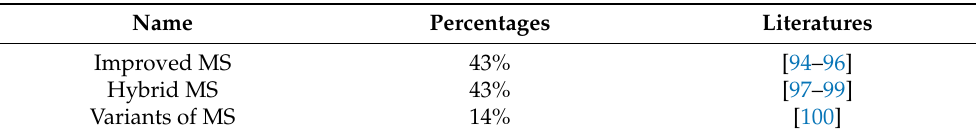
Table 2. The classification proportions for different variants of